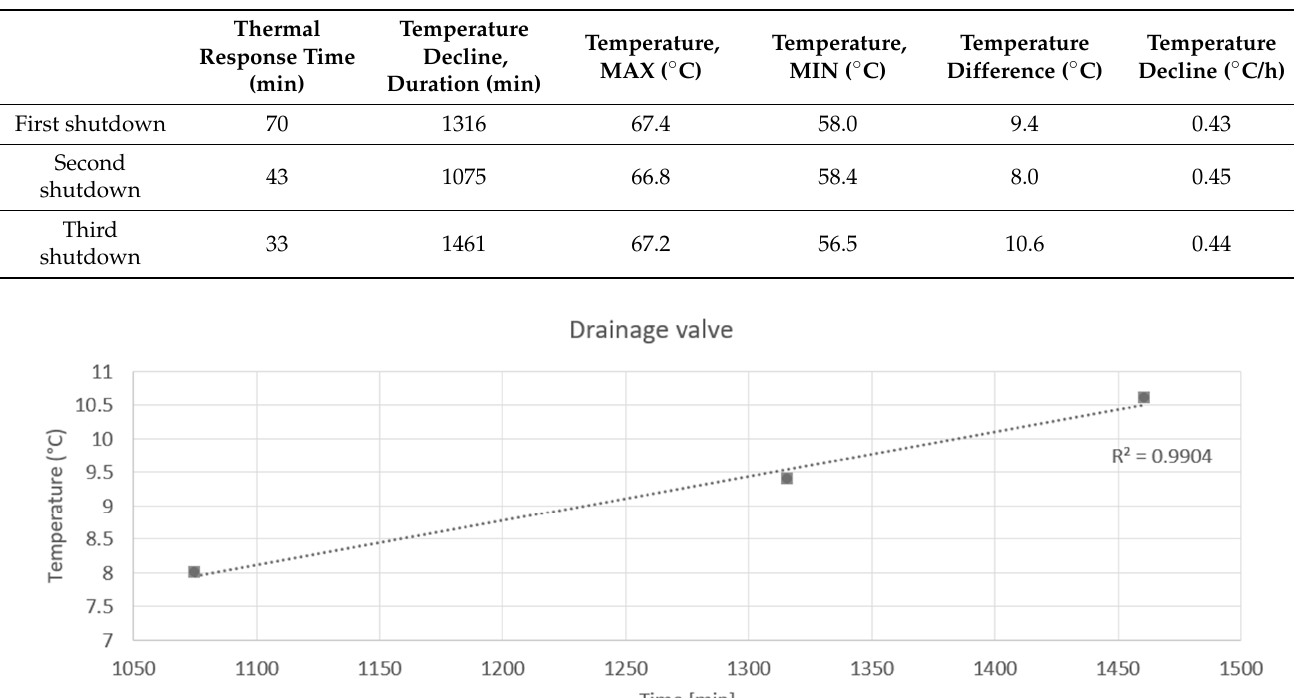
Table 5. The three shutdowns with thermal response times to temperature declines, and temperatures at the shutdown valve.